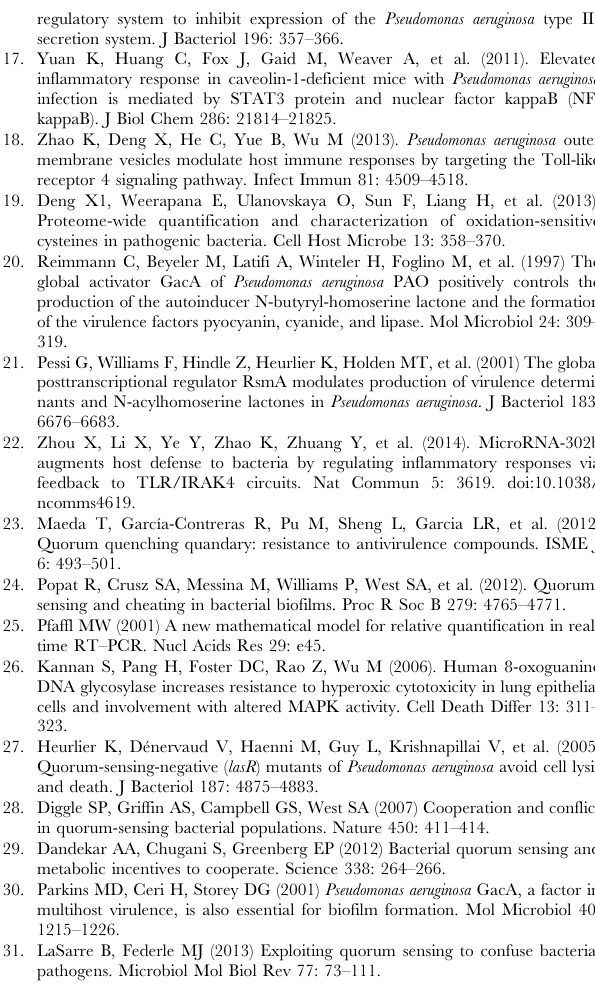
ing 1% adenosine as the sole carbon source. All the data are represented as means 6 SEM, three replicates per culture. *, P , 0.001, one-way ANOVA (Tukey-Kramer post hoc). Table S1 Specific RT-PCR primers used in this study. (DOCX) Table S2 Spearman’s correlation between the expres- sion levels of different QS related genes during the growth of WT